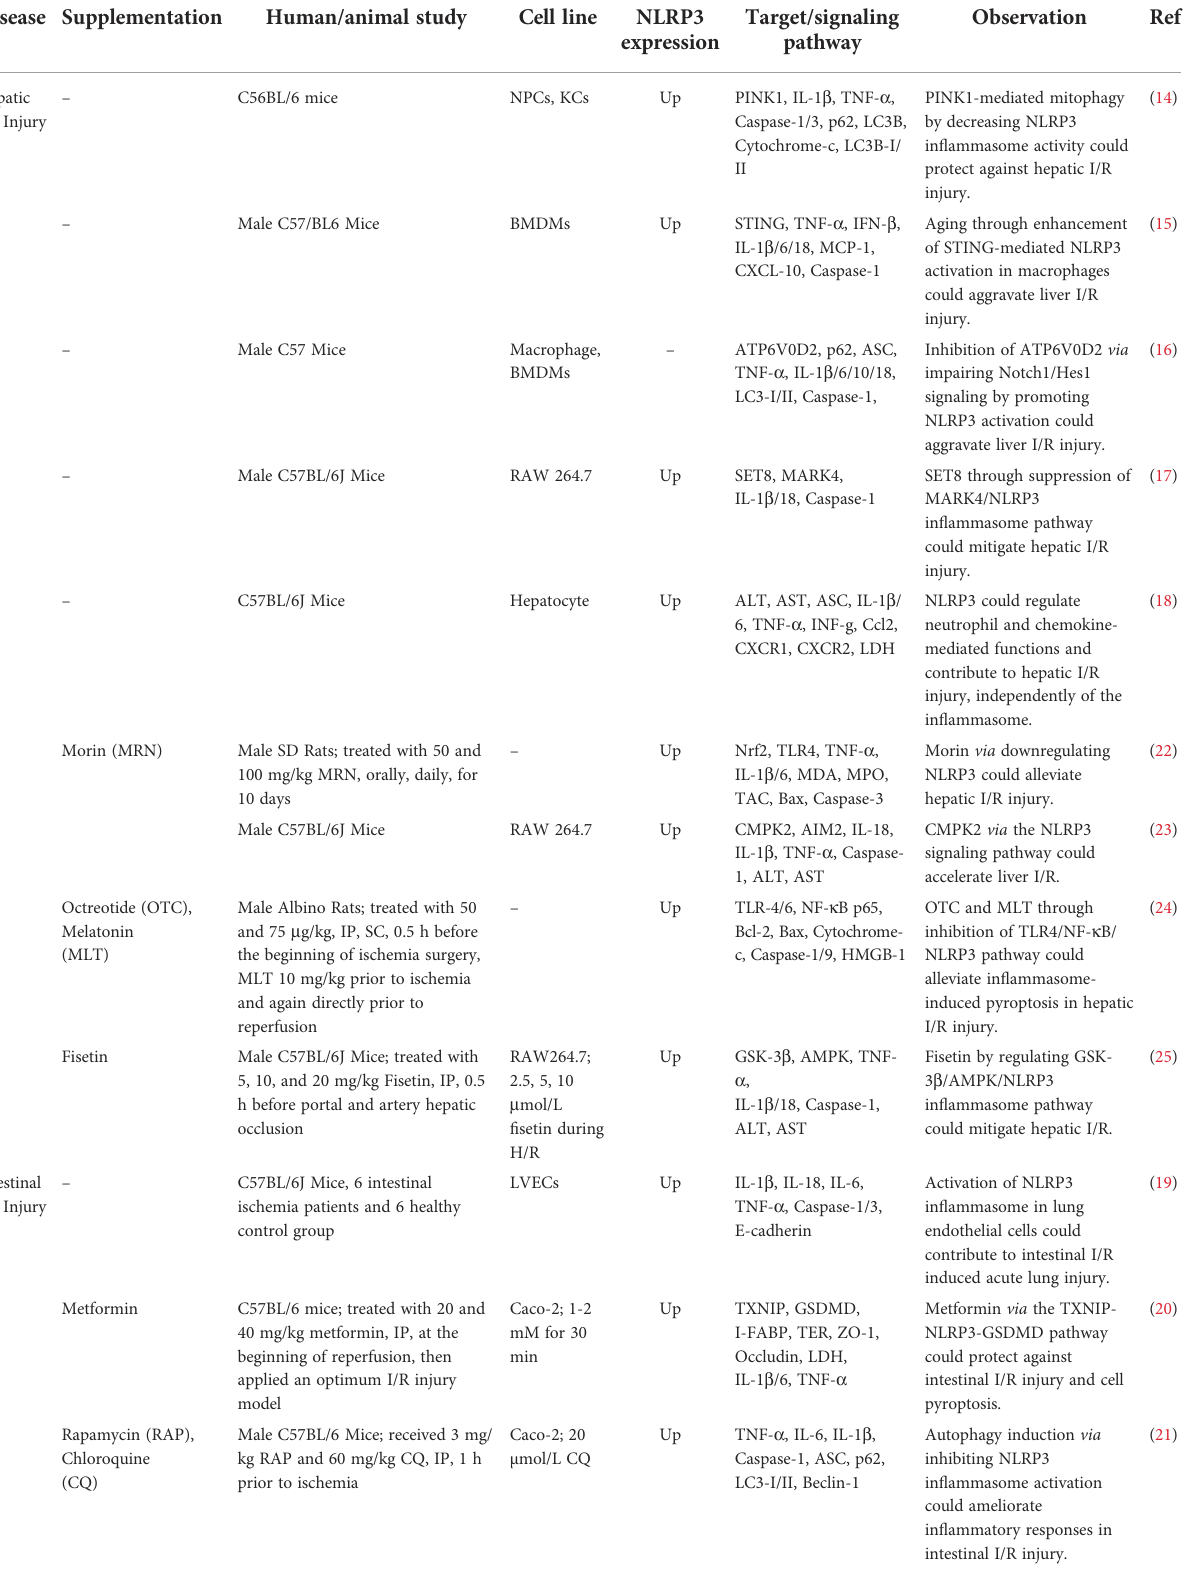
TABLE 1 Role of NLRP3 in Gastrointestinal I/R